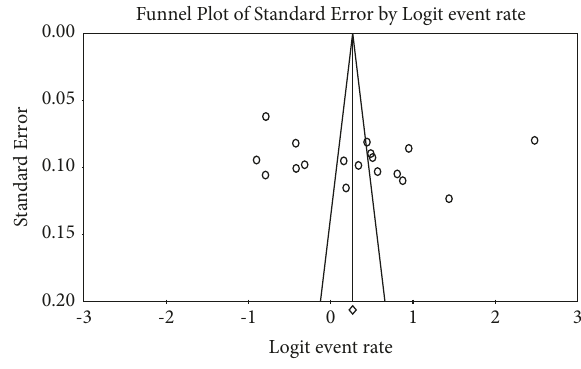
Funnel Plot of Standard Error by Logit event rate